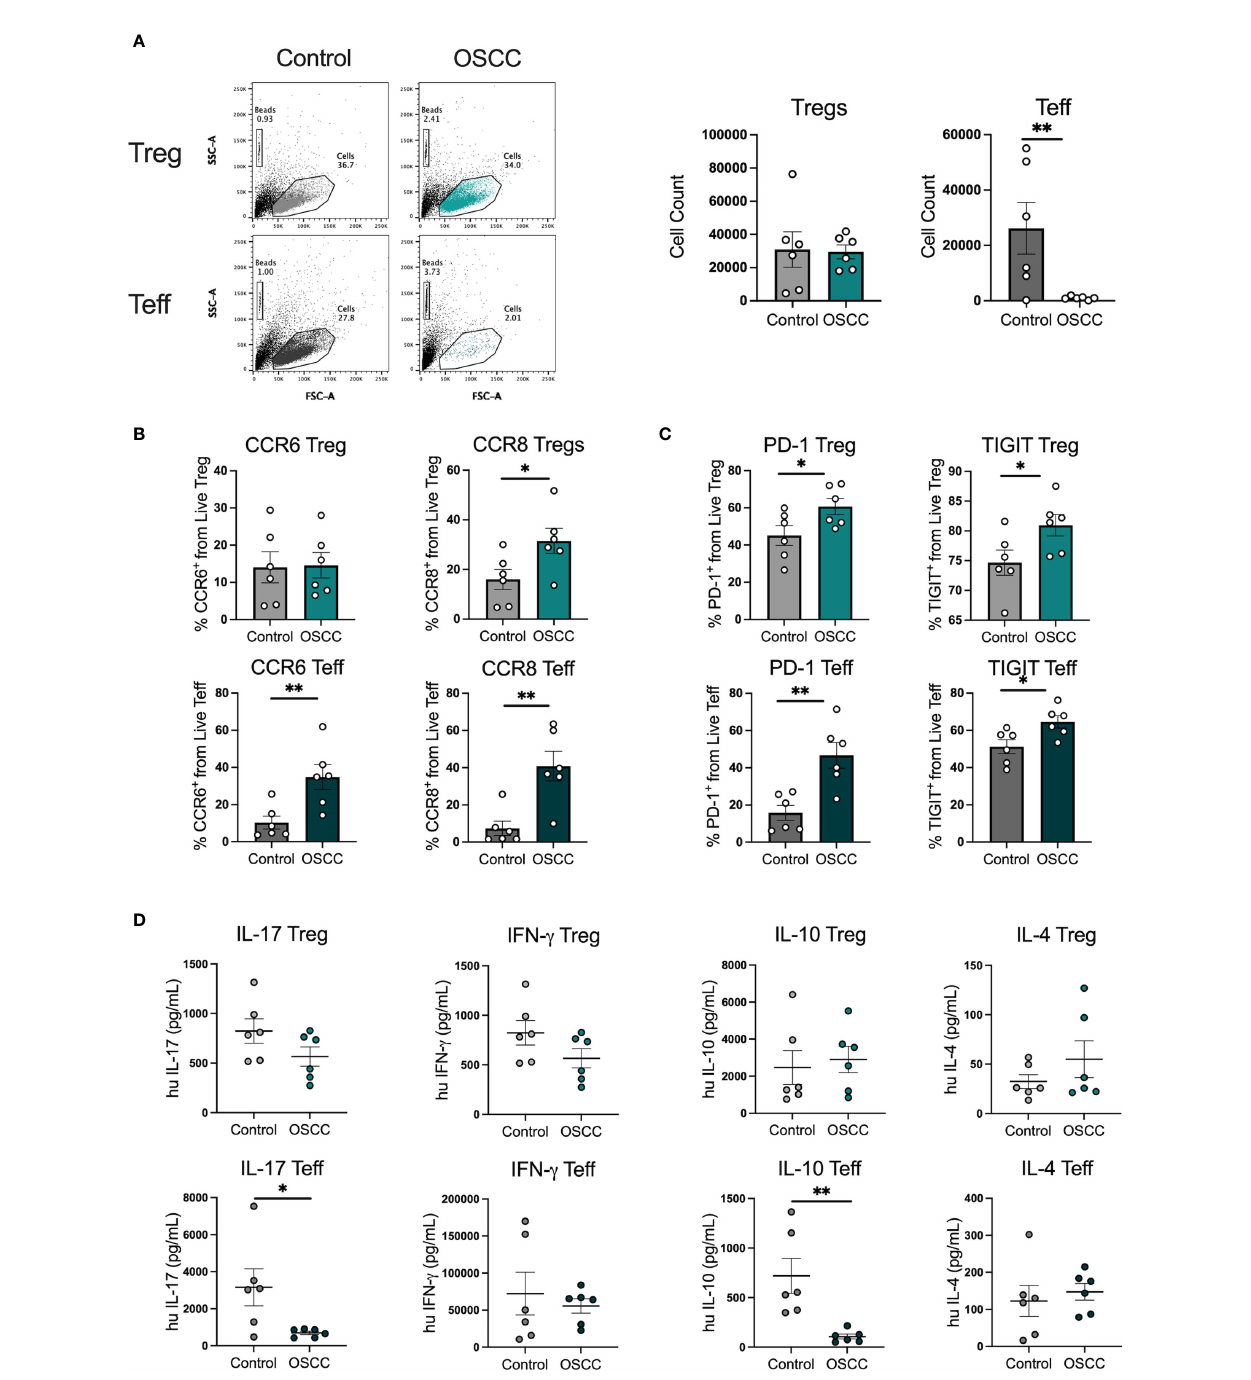
FIGURE 4 | Pre-treatment with OSCC secretome affects Teff cell counts but CCR8, PD-1 and TIGIT expression is maintained after secretome removal in Treg and Teff. (A) Representative dot plots and cumulative data of Tregs and Teff cell counts after 48h of culture after removal of control or OSCC secretome. Brie fl y, sorted Tregs and Teff were pre-activated with anti-CD3/CD28 beads (1:5) in the presence of IL-2 (1000U). After activation, 1x10 5 Tregs and Teff were co-cultured with secretomes from OSCC or control samples for 48h. Then, cells were washed and Tregs and Teff were cultured with anti-CD3/CD28 beads (1:5) in the presence of IL-2 (1000U) for 48h. (B) CCR6 and CCR8 expression was measured by fl ow cytometry in live Tregs and Teff. (C) PD-1 and TIGIT expression was measured by fl ow cytometry in live Tregs and Teff. (D) Supernatants of Tregs and Teff were collected and cytokines were measured with cytokine bead array. Data are presented as mean ± SEM using bars with scatter dot plots for phenotype and scatter dot plots for cytokine secretion (Unpaired t test). For all statistical tests, ∗∗ p < 0.01 and ∗ p < 0.05 were considered signi fi